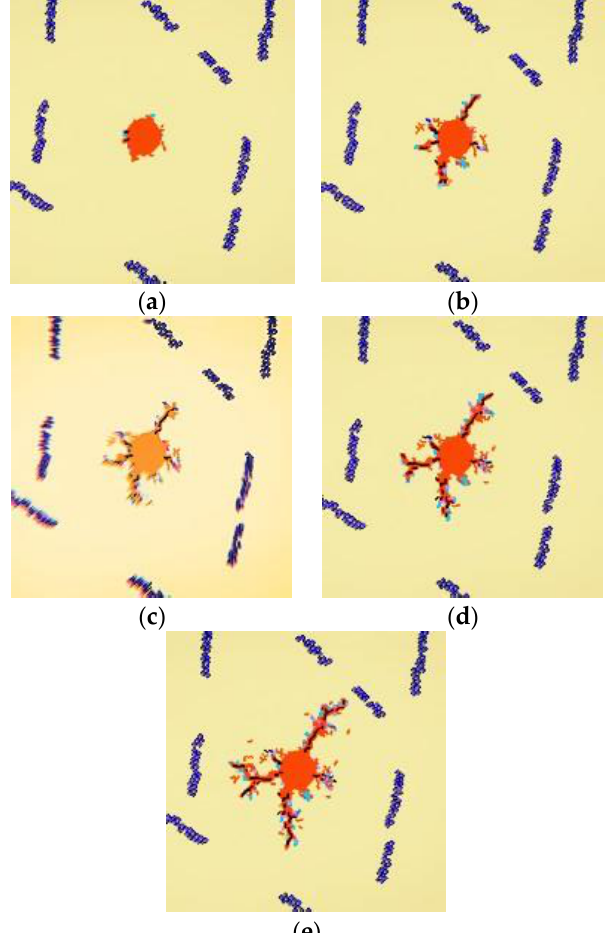
Figure 4. The fracture propagation shape of different time sub-steps for the injection pressure 45 MP. The yellow area represents the particles to be fractured; the black lines is the fracture; the blue lines connecting the round particles represent the contact connection between the particles; the red region is the wellbore. ( a ) Time substep = 100. ( b ) Time substep = 200. ( c ) Time substep = 300. ( d ) Time substep = 400. ( e ) Time substep = 500.